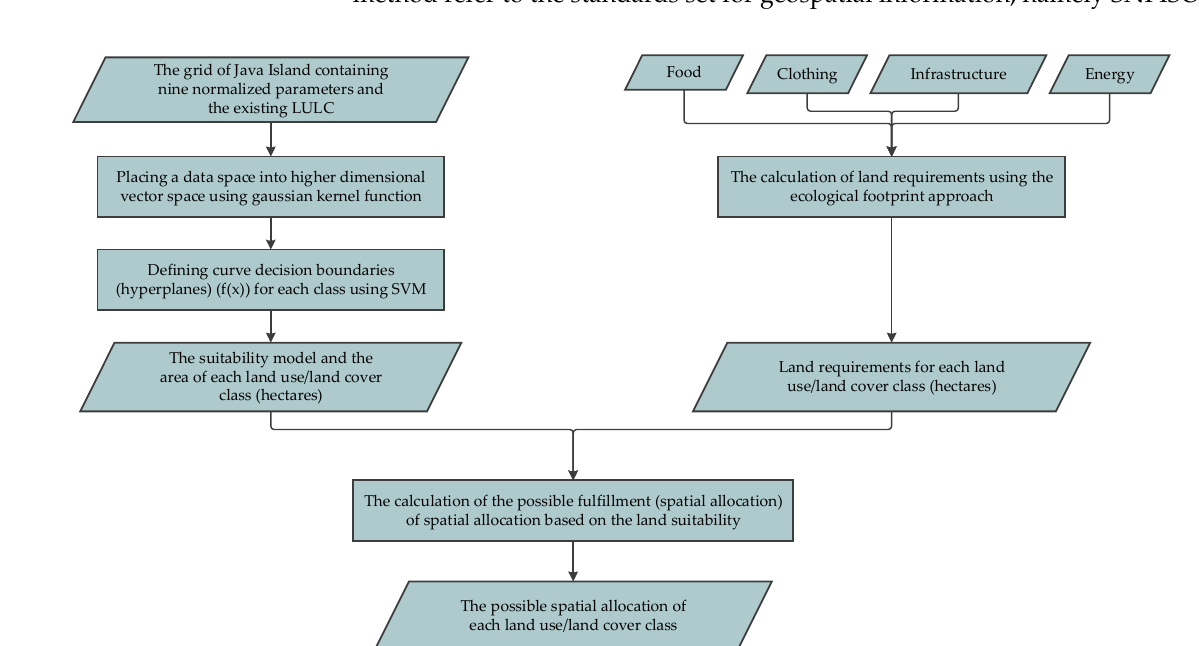
Figure 6. The workflow to calculate spatial allocation based on physiological needs and land suitability using the combination of ecological footprint and support vector machine (SVM). LULC, land-use/land cover.